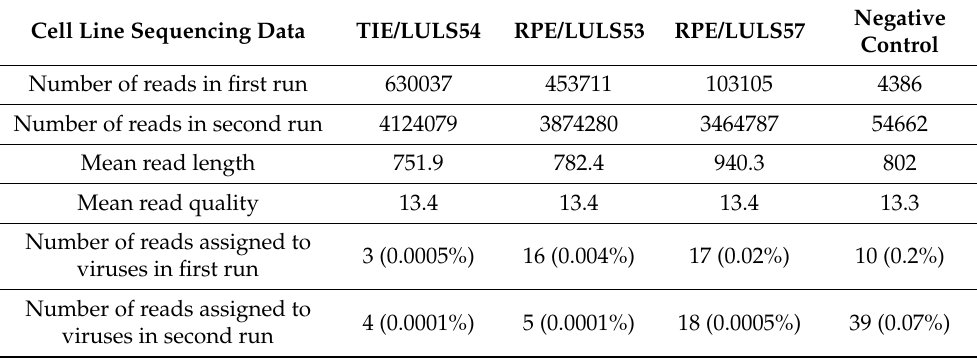
Table 2. Summary of RNAseq data obtained by Nanopore sequencing of RNA extracted from Triatoma infestans cell line TIE/LULS54 and Rhodnius prolixus cell lines RPE/LULS53 and RPE/LULS57. Two sequencing runs were carried